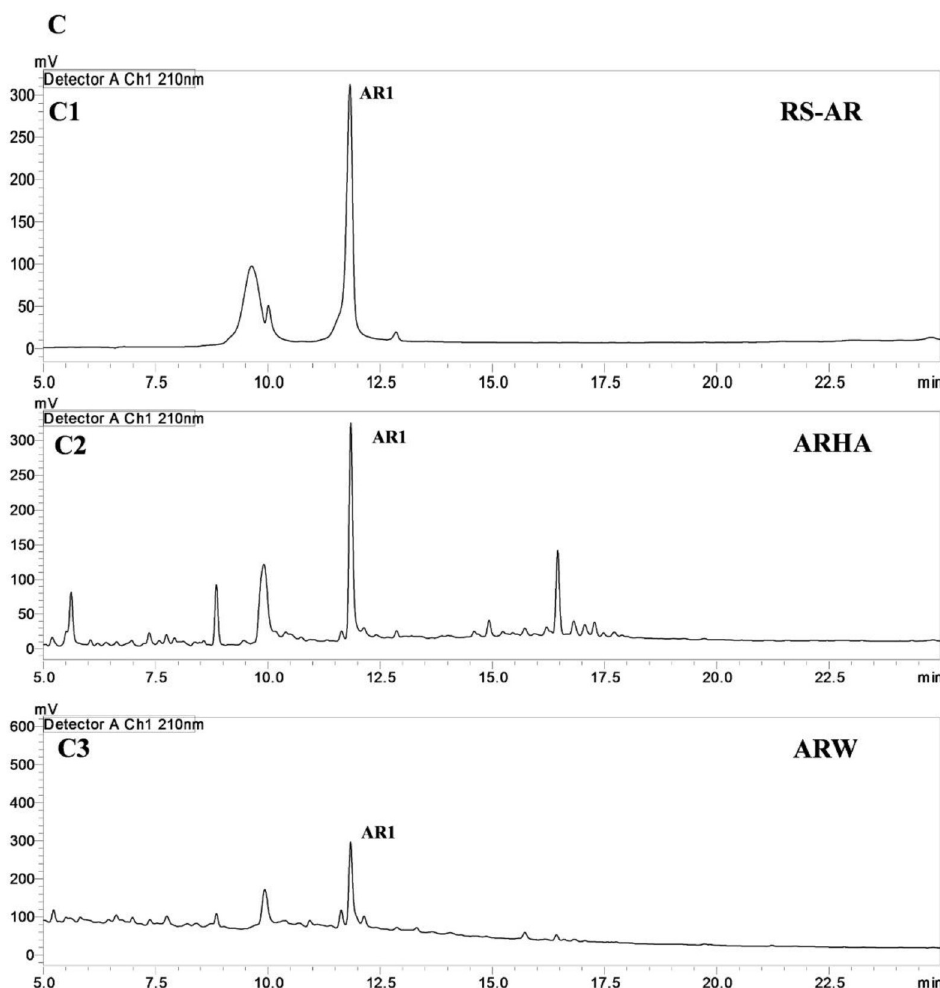
Fig 3. UHPLC − PDA chromatogram of reference compounds (RS) and samples with detection for ( C ) Asparagus racemosus at 210 nm for AR-1 in the ( C1 ) reference compound AR1 ( C2 ) ARHA ( C )3 ARW; where shatavarin-IV ( AR1 ). AR, TC and WS a network pharmacology approach was followed [47]. As a first step, potential protein targets of bioactives were identified using the BindingDB server. The targets identified were mapped to known immune pathways that were extracted from the KEGG database and plotted using Cytoscape. The retrieved data showed total 29 bioactives from Rasayana botani- cals associated with 306 unique human protein targets. Of these, 53 protein targets of 28 bioac- tives were found to be involved in 20 immune pathways referred as immune targets (Fig 10). The detailed mapping of phytoconstituents from each plant with targets and the number of associations reveals that bioactives from Withania somnifera show the largest number of asso- ciations (Fig 11A). The distribution of immune targets amongst Rasayana botanicals is shown Fig 11.